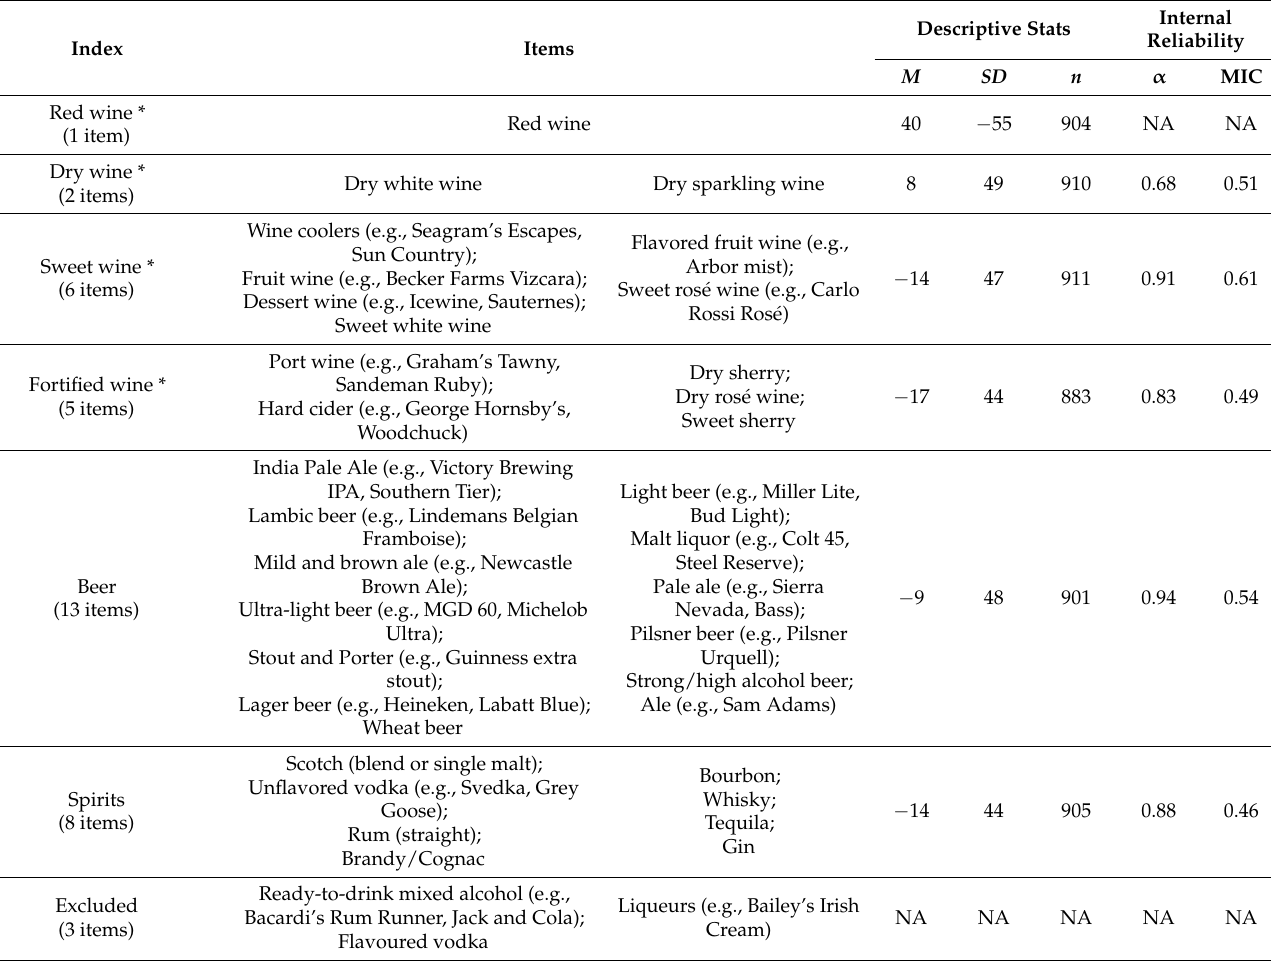
Figure A3. Boxplots showing the mean self-reported liking scores (gDOL) for red wine ( n = 904), dry wine ( n = 910), sweet wine ( n = 911), fortified wine ( n = 883), beer ( n = 900), and spirits ( n = 905). Table A1. Summary of alcoholic beverage liking indices (MIC = mean interitem correlation, α = Cronbach’s alpha). * Wine-related products were divided into four indices based on the clusters identified by Pickering et al. [45] in the same dataset.